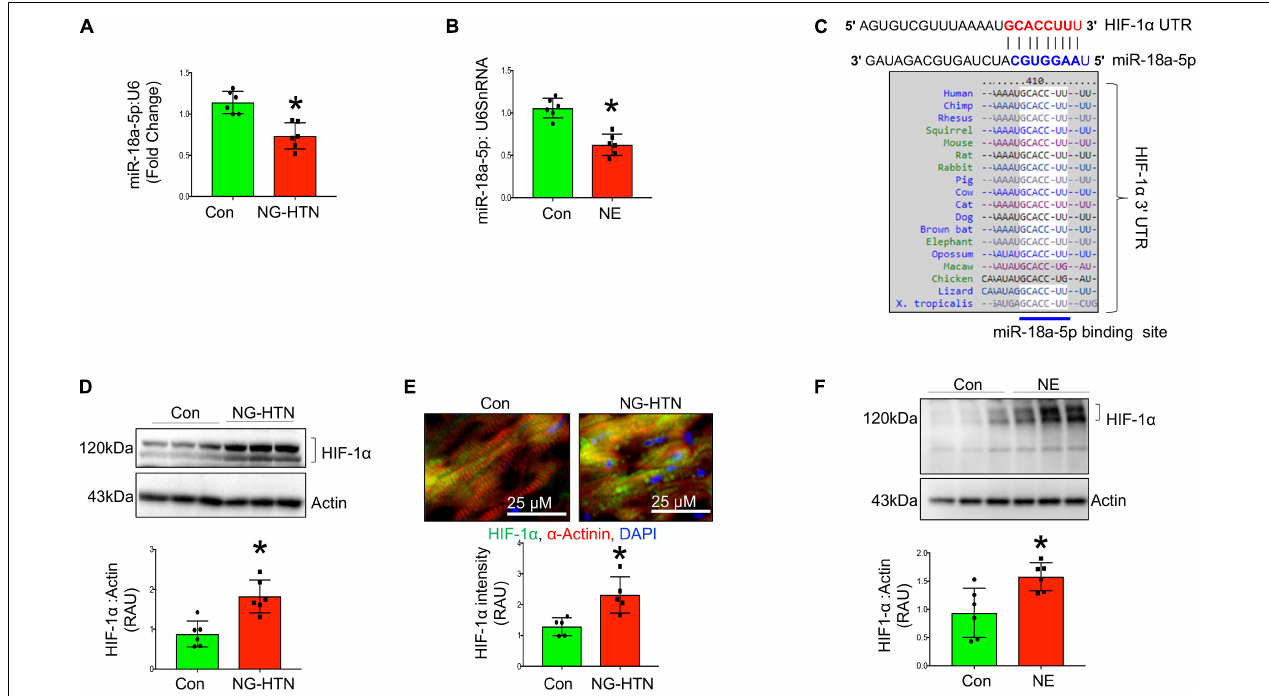
FIGURE 9 | Neurogenic hypertension (NG-HTN) and miR-18a-5p/HIF-1 α axis. (A) Quantification of miR-18a-5p level in control and NG-HTN hearts normalized to U6SnRNA. (B) Quantification of miR-18a-5p level in control and NE-treated H9c2 cardiomyocytes normalized to U6SnRNA. (C) In silico prediction of miR-18a-5p binding on 3 (cid:48) UTR of HIF-1 α and its species conserveness. (D) Western blot and quantification showing expression of HIF-1 α in control and NG-HTN rats normalized to Actin. (E) Immunofluorescence assay and quantification showing HIF-1 α localization in control and NG-HTN hearts (HIF-1 α , green; α -actinin, red; and DAPI, blue).